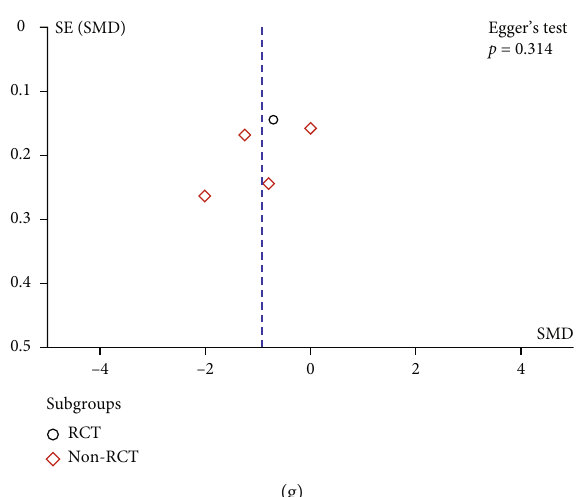
Figure 4: Funnel plots and Egger ’ s test were used to assess publication bias of (a) TTH, (b) TTA, (c) TTD, (d) total vascular complication rate, (e) major vascular complication rate, (f) bleeding-related complication rate, and (g) patient-reported